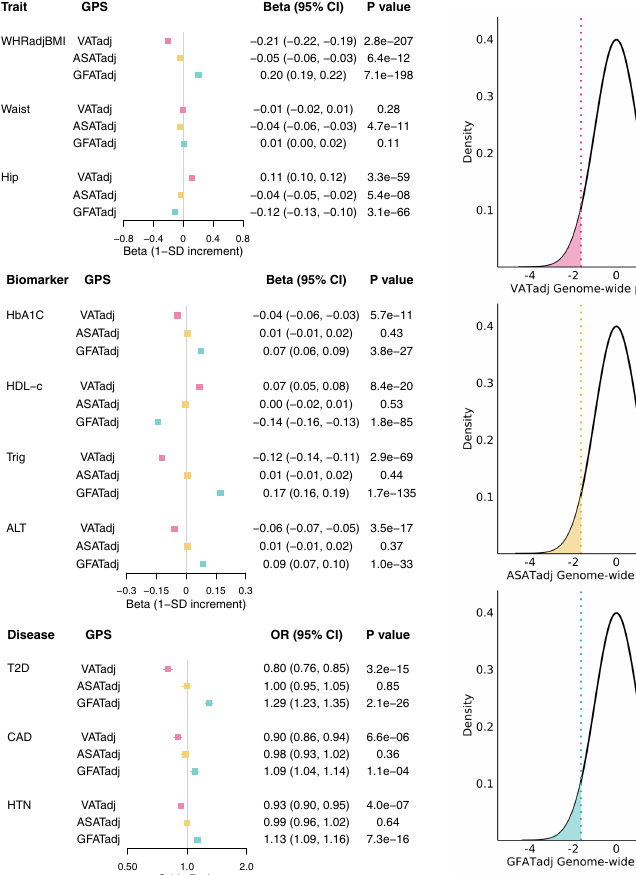
− 0.10 – − 0.07; p = 7.9 × 10 − 36 ), lower risk of type 2 diabetes (OR: 0.75; 95% CI: 0.70 – 0.79; p = 1.3 × 10 − 23 ), and lower risk of coronary artery disease (OR: 0.89; 95% CI: 0.85 – 0.93; p = 1.6 × 10 − 6 ). By contrast, those in the top 5% of the VATadj polygenic score tended to have increased risk of these disease outcomes with odds ratios for type 2 diabetes, coronary artery disease, and hypertension of 1.18, 1.12, and 1.09, respectively. We aimed to externally validate associations with VATadj, ASATadj, and GFATadj polygenic scores in 7888 White participants of the Atherosclerosis Risk in Communities (ARIC) study 72 . Each polygenic score was associated with HDL- cholesterol, triglycerides, and type 2 diabetes in ARIC. Results were broadly consistent with the UK Biobank with the strongest associations observed with the GFATadj polygenic score — individuals in the top 10% of the GFATadj polygenic score had higher HDL-cholesterol (beta: 0.14 SD, 95% CI: 0.07 – 0.22, p = 1.5 × 10 − 4 ), lower serum triglycerides (beta: − 0.16 SD; 95%